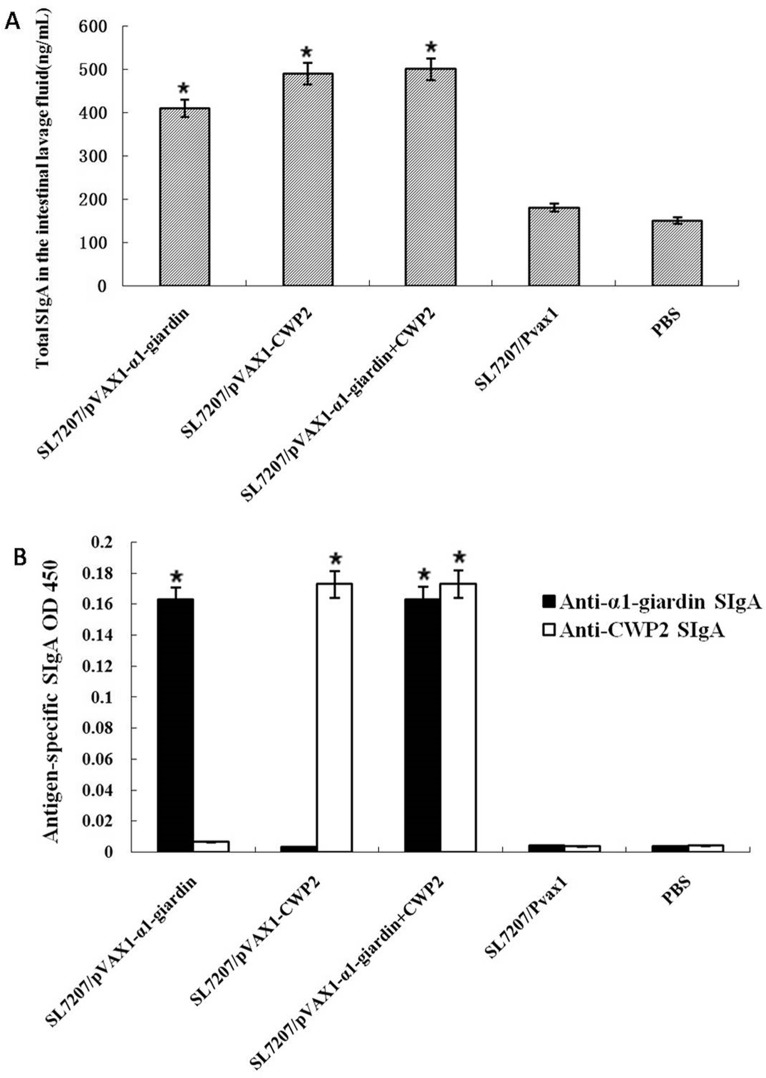
Intestinal mucosa secreted total IgA (SIgA) (A) and antigen-specific SIgA (B, 1:100 dilution) were measured in the intestinal lavage fluids collected from mice vaccinated with SL7207 carried a1-gardin and CWP2 DNA vaccines measured by ELISA. Values shown for each group are the mean ± SE of antibody levels (n = 10) (*p<0.05).